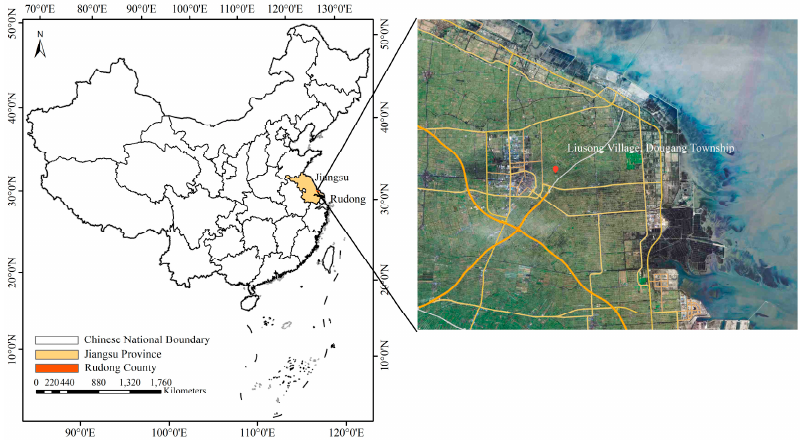
Figure 1. The location of the studied coastal reclamation area in Liuzong Village, Juegang town, Rudong Country, Jiangsu Province, China.